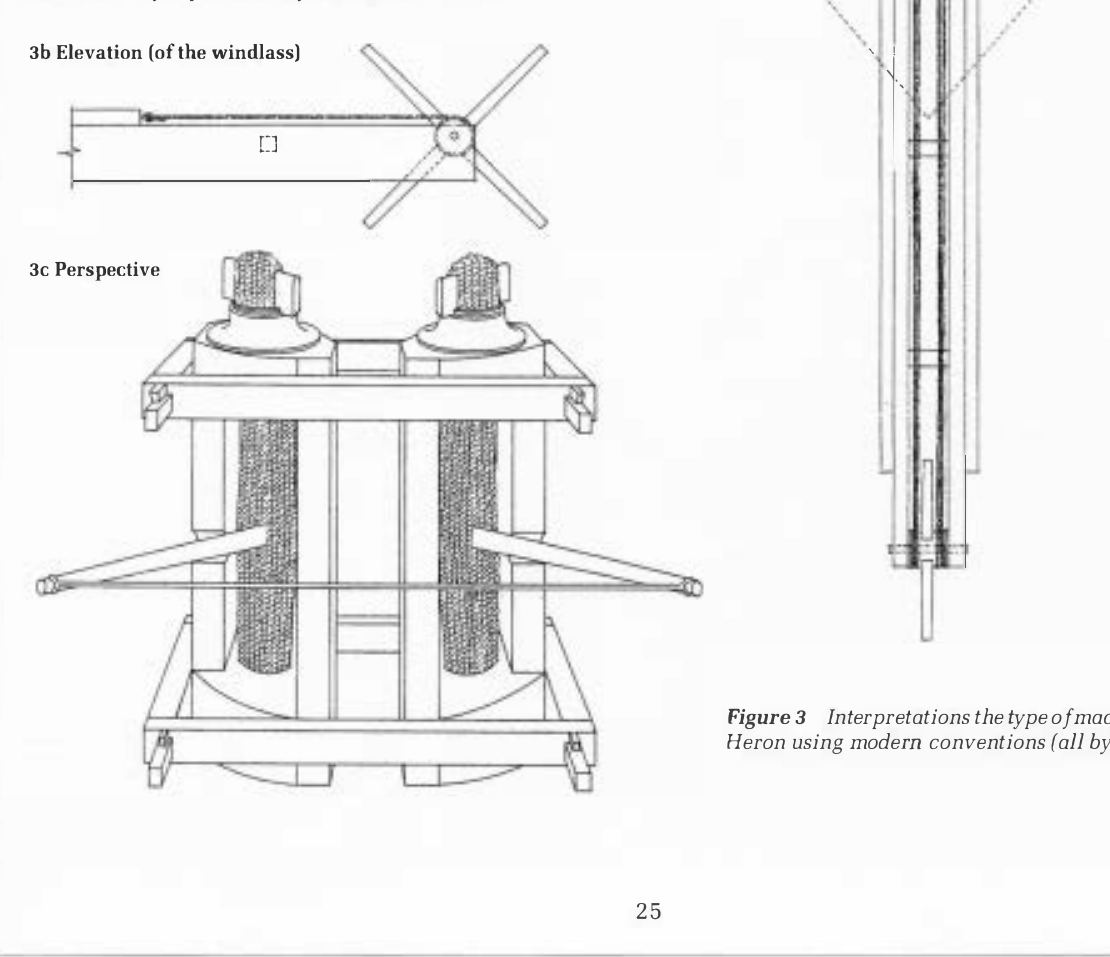
Figure 2 Redrawing (by Digby Stevenson) of the palintone ballista, as described by Heron in the Belopoeica, based on figure 31 in La policetique des Grecs, C. Wescher (Paris: l'Imprimerie Imperiale, 1867). Wescher's illustration is a composite derived from two of the original manuscript ver­ sions, Codex P76 v. and Codex V.115 v. The former version is conveniently reproduced by Schramm (seen. 3).